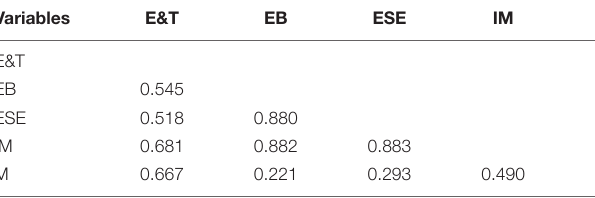
TABLE 4 | Heterotrait-Monotrait